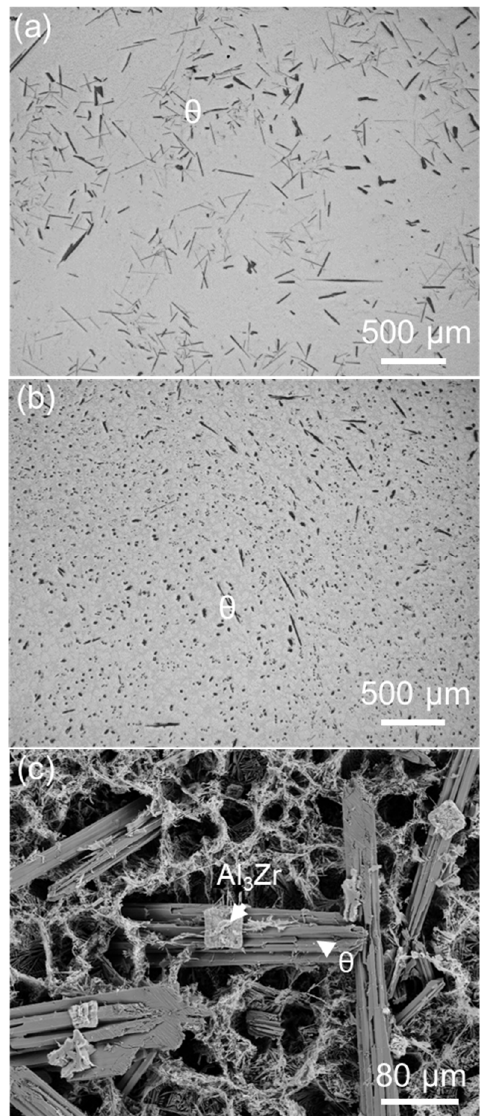
Figure 17. Grain refinement of θ by enhancing the heterogeneous nucleation on Al 3 Zr particles in Al ‐ 4Fe alloy with 0.5 wt.% Zr addition. ( a ) optical micrograph of Al ‐ 4Fe solidified at 3.5 K/s, ( b ) optical micrographs of Al ‐ 4Fe ‐ 0.5Zr solidified at 3.5 K/s showing the refinement of Fe ‐ containing particles with the Zr addition; and ( c ) SEM image of deep ‐ etched Al ‐ 4Fe ‐ 0.5Zr alloy showing the θ‐ Al 13 Fe 4 particles associated with Al 3 Zr particles. [102].